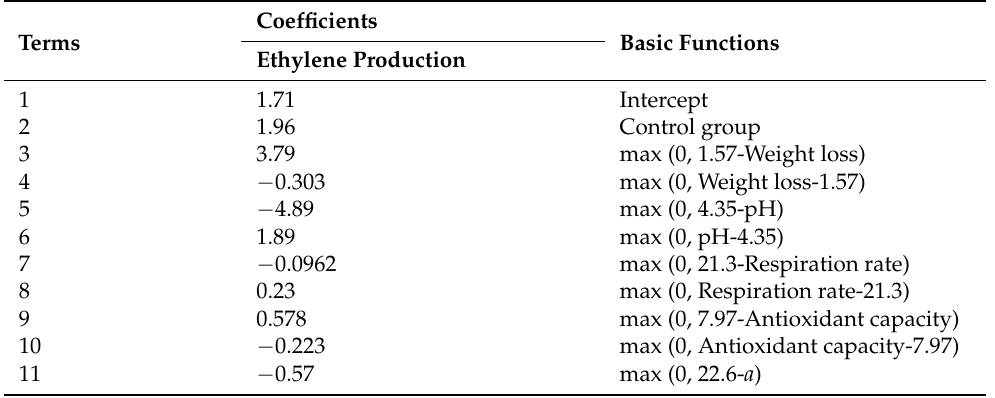
Table 6. Basic functions and corresponding coefficients of the Multivariate Adaptive Regression Splines (MARS) model for ethylene production prediction in tomato fruit during storage